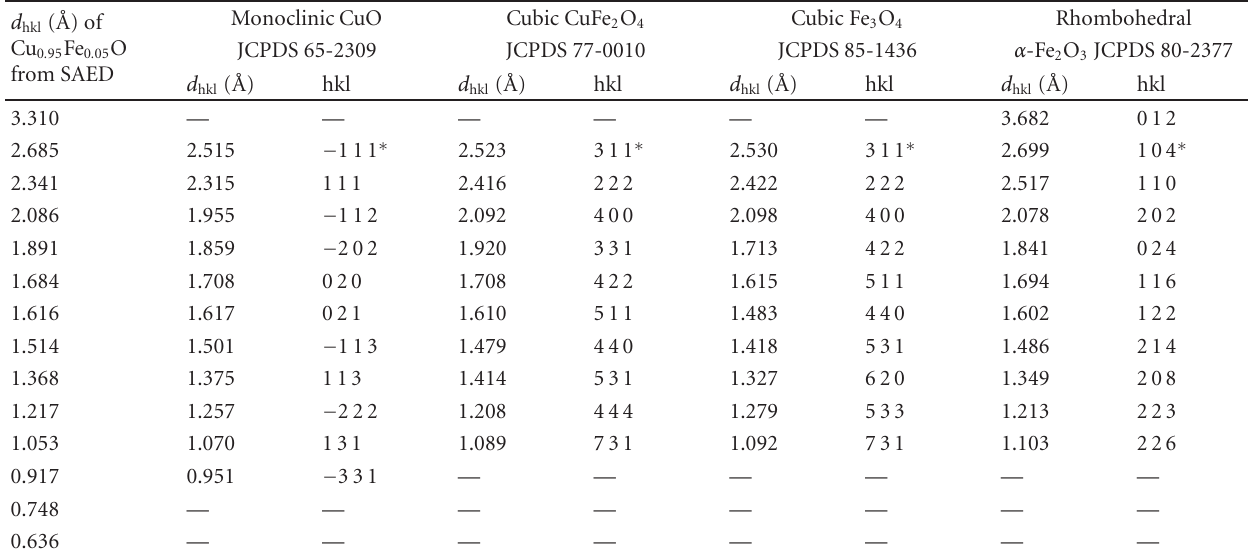
Table 4: d hkl and hkl values of nanocrystalline Cu 0 . 95 Fe 0 . 05 O shown in comparison with possible secondary phases to indicate the closely situated d hkl planes.